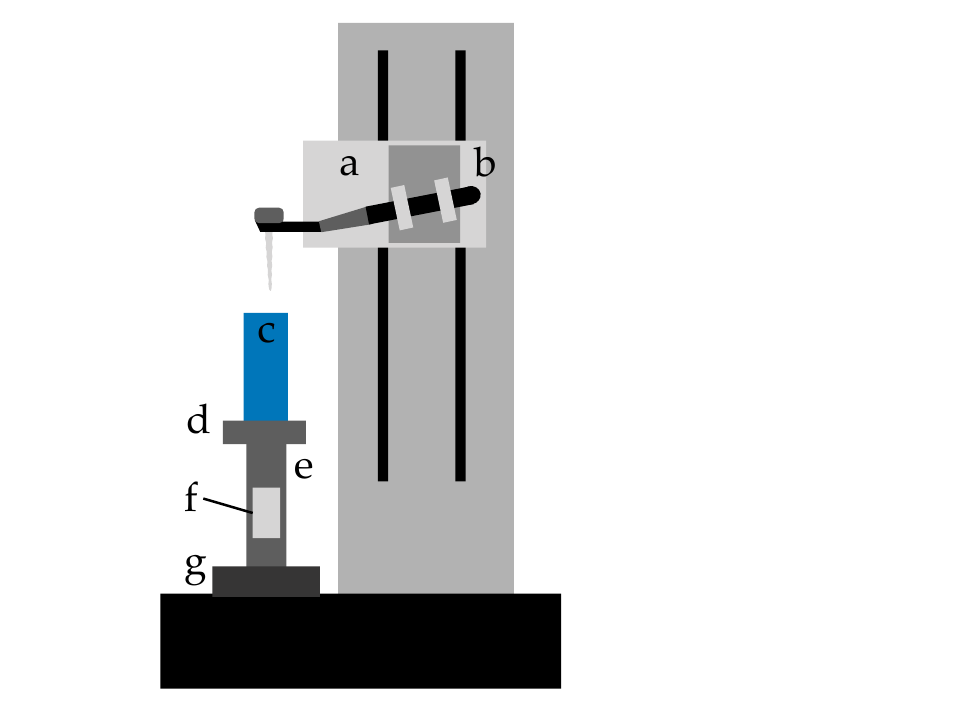
Figure 2. Automated root canal instrumentation device with a torque/force analyzing unit. (a) moving stage; (b) endodontic motor; (c) canal model; (d) metal stage; (e) metal cylinder; (f) strain gauge; (g) load cell. The metal stage (d), on which a canal model (c) was fixed, was connected to the load cell for force measurement (g) with a metal cylinder (e). The metal cylinder had a flattened portion in its center, where the strain gauges for torque measurement (f) were adhered.